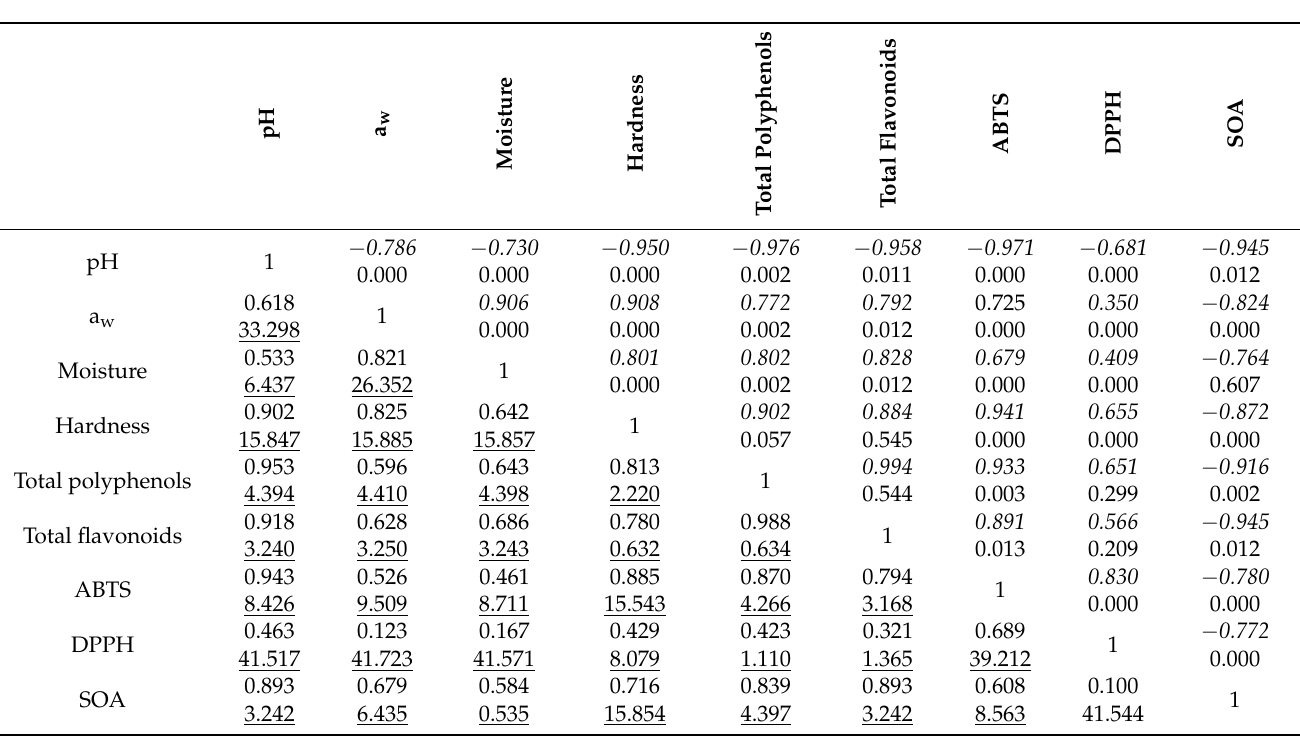
Table 8. Correlation